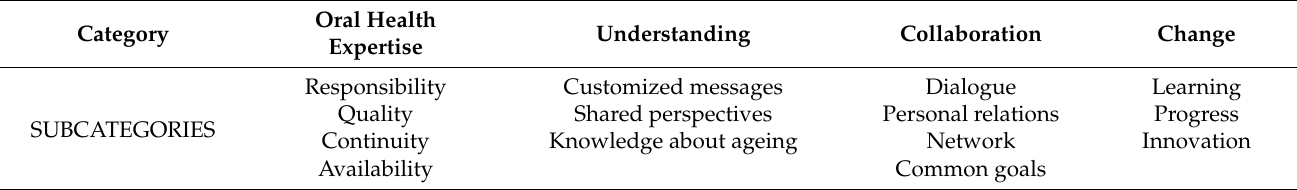
Table 4. Identified categories and